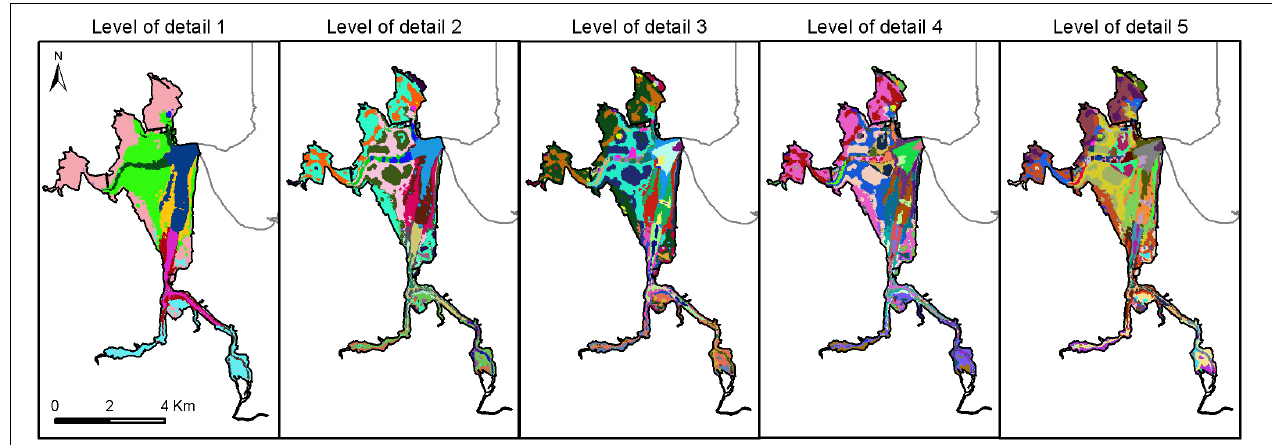
FIGURE 4 | Spatial distribution of physiotopes in the Santoña estuary at five scales (10, 23, 57, 77 y 93 biotopes from level 1 to level 5, respectively). Different colors represent different physiotopes within each level of detail.